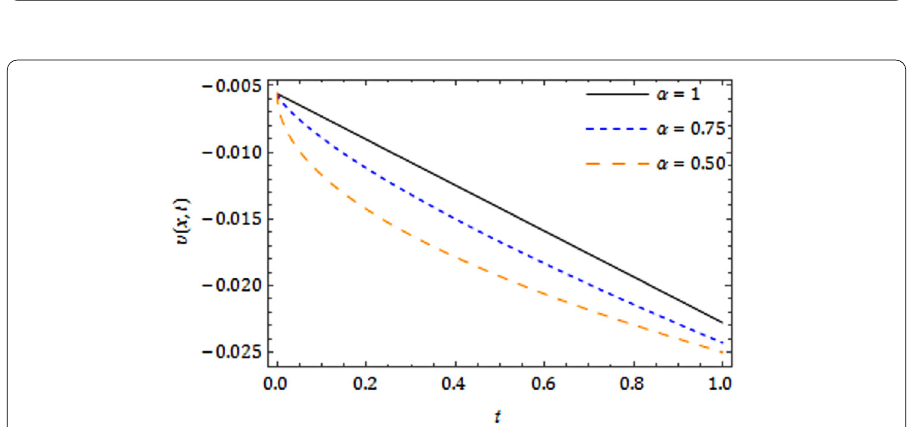
Figure 12 Plot of u ( x , t ) with respect to t at diverse values of α when ω = 0.005, (cid:13) = 0.1, c = 10, n = 1, (cid:2) = –1 and x = 1 for Example 6.2